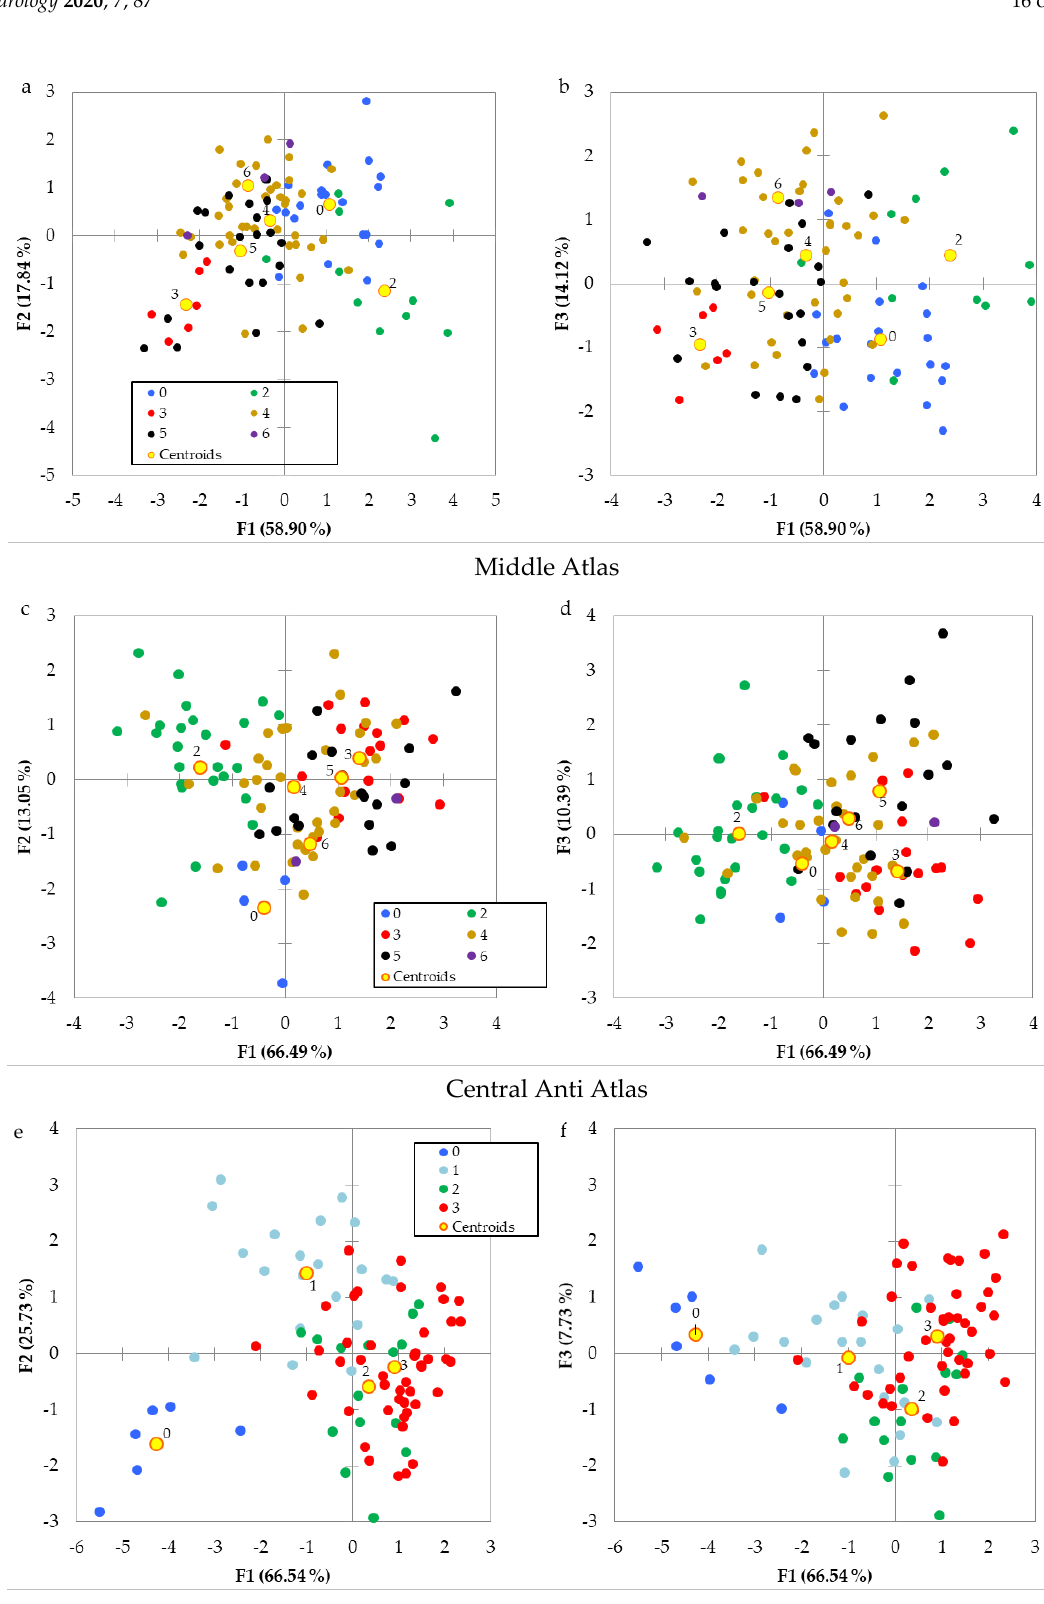
Figure 10. Distribution of the observations and centroids of each type of drainage network pattern in F1–F2 and F1–F3 score plots of the External Rif ( a , b ), Middle Atlas ( c , d ), and the Central Anti-Atlas ( e , f ). (0 = Dendritic, 1 = Pinnate, 2 = Parallel, 3 = Trellis, 4 = Rectangular, 5 = Herringbone, 6 = Barbed).